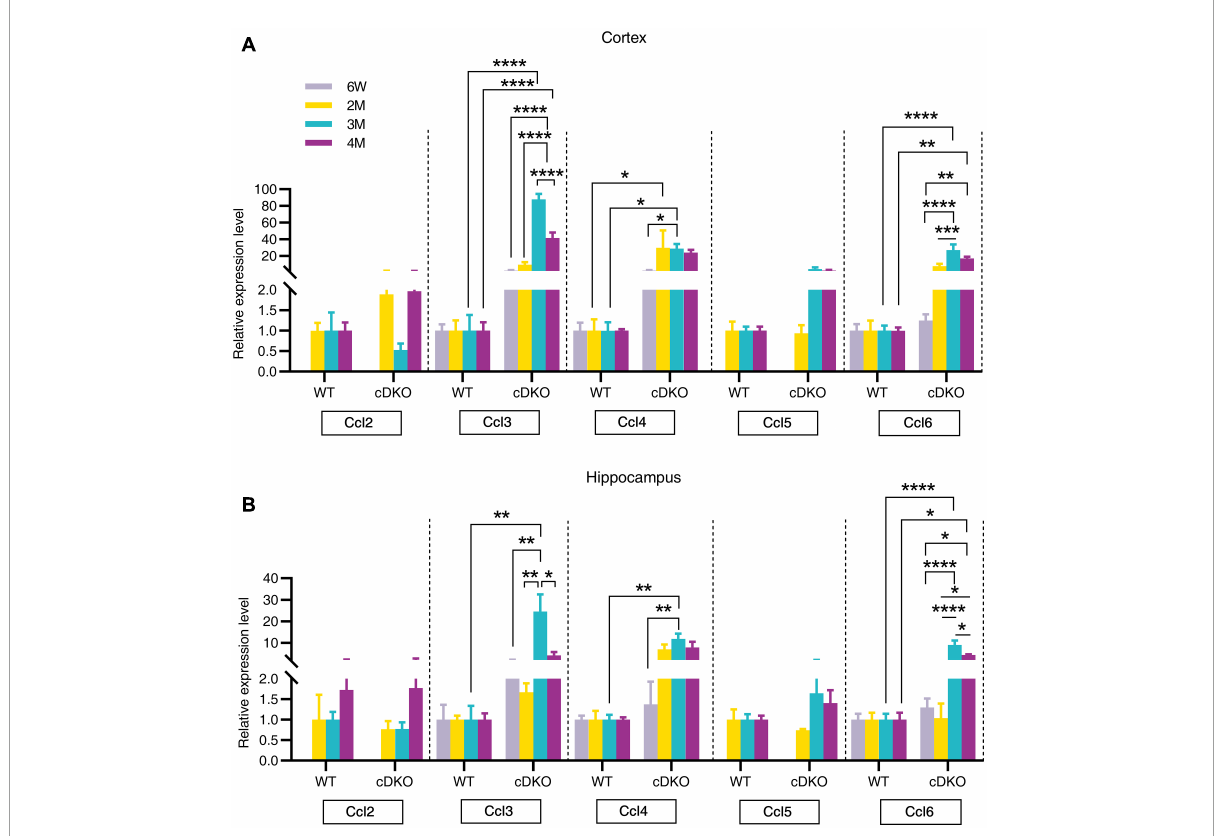
FIGURE5 Age-related increase in mRNA expression of chemokine genes in the cortex and hippocampus of cDKO mice. (A,B) Relative expression of chemokine gene Ccl2, Ccl3, Ccl4, Ccl5, and Ccl6 normalized to GAPDH in the cortex (A) and hippocampus (B) of WT and cDKO mice at the ages of 6 weeks, 2, 3, and 4 months analyzed by RT-PCR. Data are presented as the mean ± SEM ( n = 3–5 for each group). One-way ANOVA analysis followed by Turkey’s test, * p < 0.05, ** p < 0.01, *** p < 0.001, **** p <